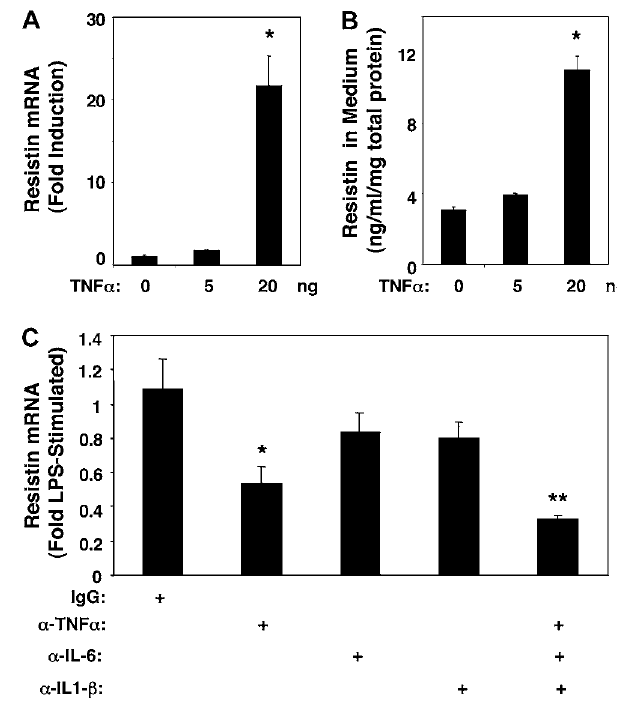
Figure 3. Endotoxin-Induced Cytokines Regulate Resistin